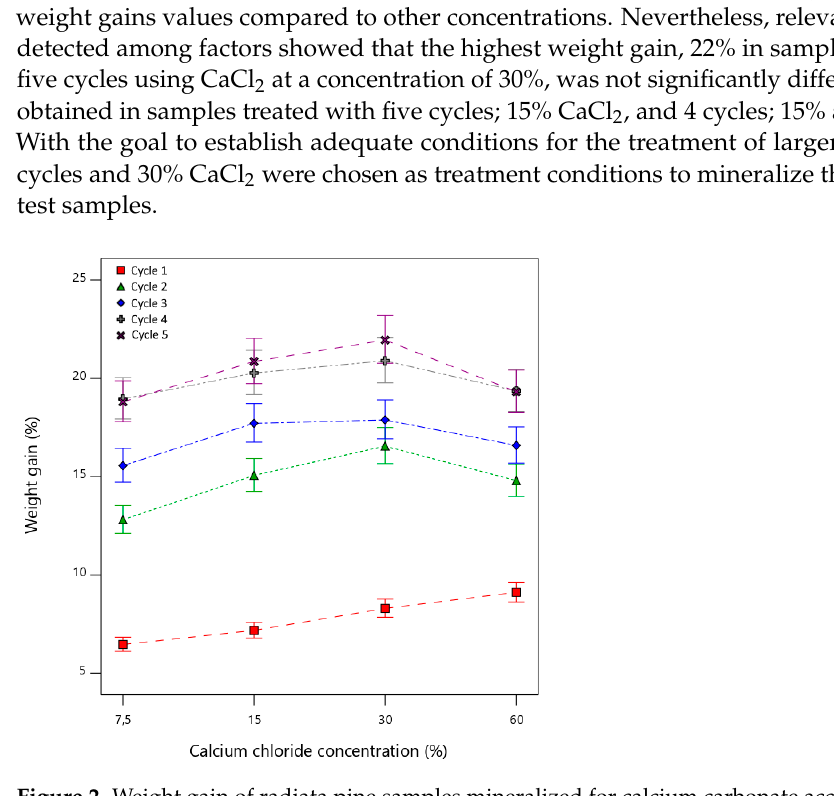
Figure 2. Weight gain of radiata pine samples mineralized for calcium carbonate accumulation. Error bars depict the least significant difference (l.s.d.) after analysis of variance ( p < 0.05).